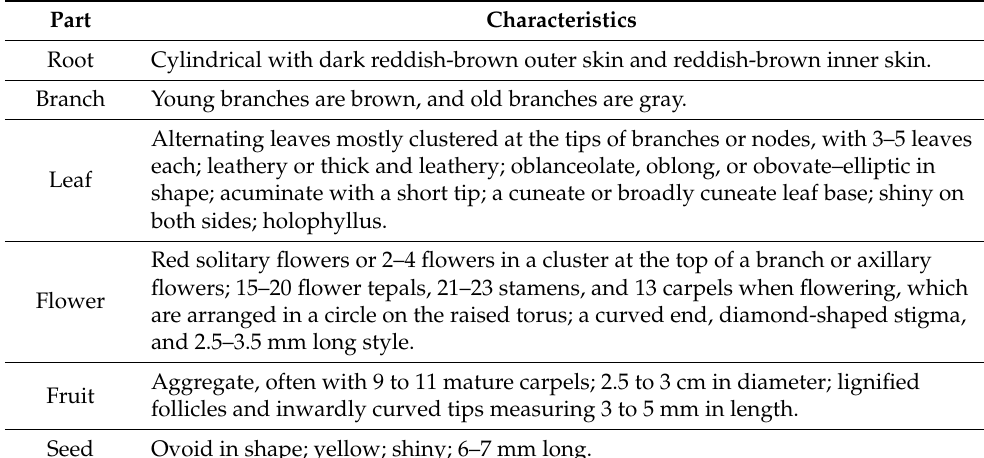
Table 1. Morphological characteristics of I. difengpi (Illiciaceae)